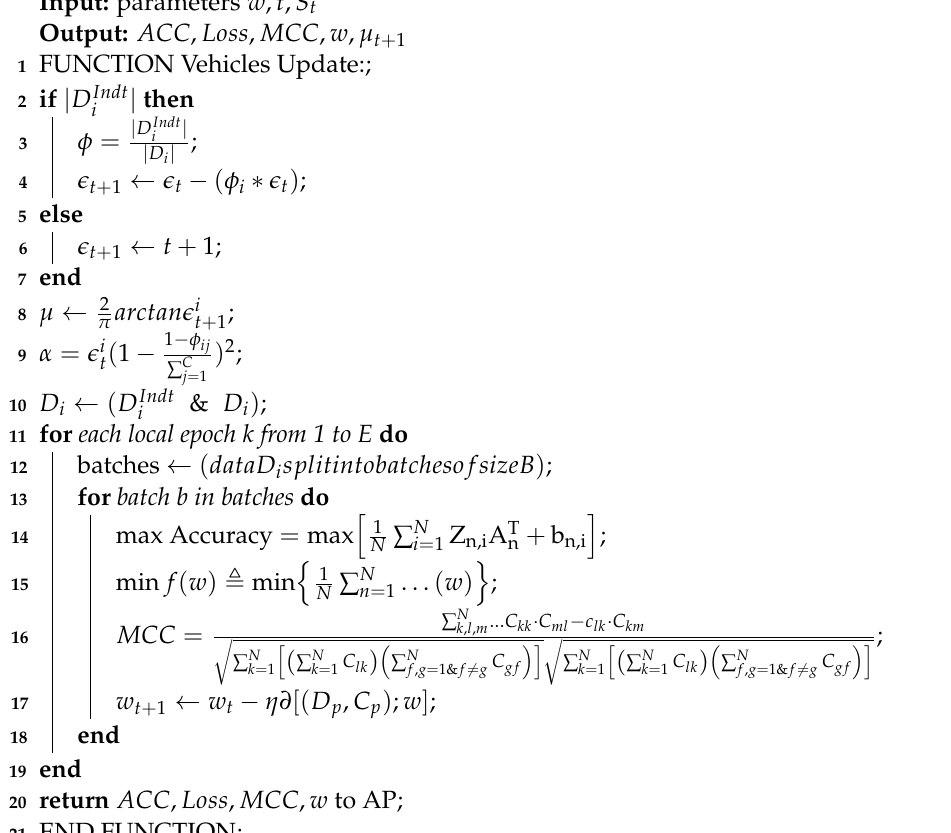
Algorithm 2: AP Node-Vehicle Diversity Selection Algorithm